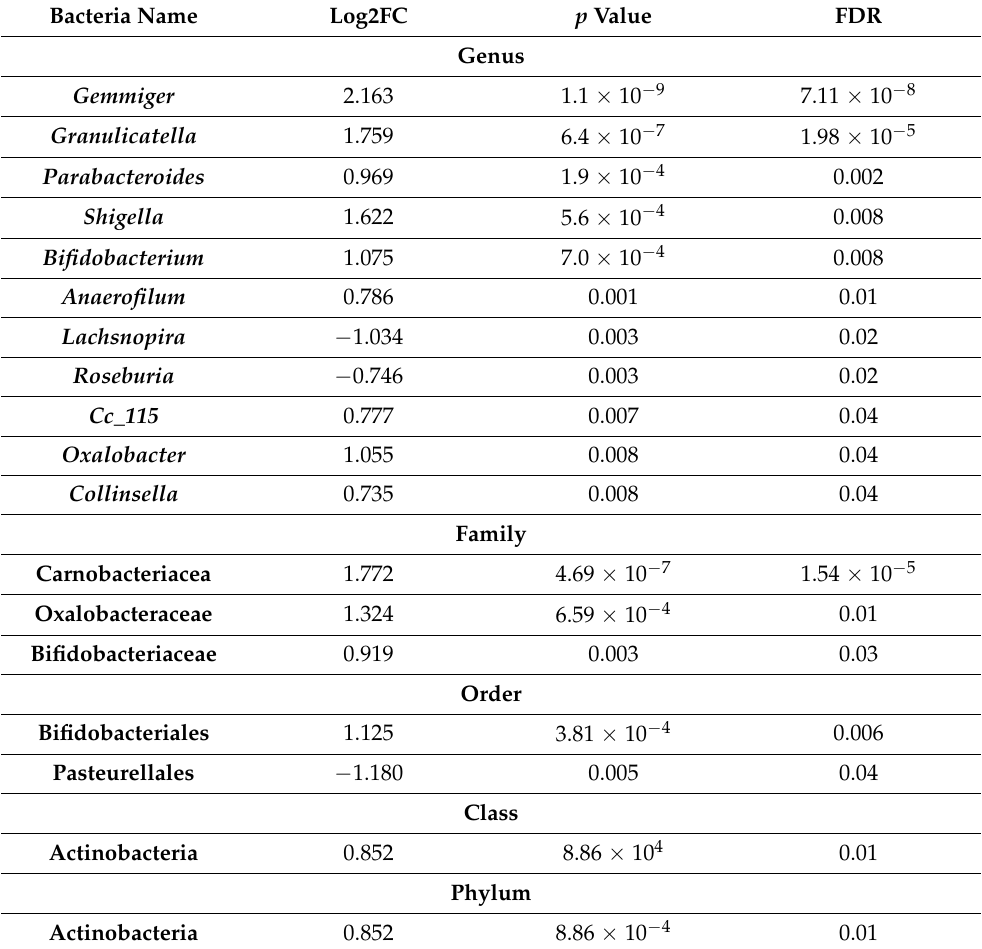
Table 3. Bacterial taxa significantly different between subjects who consumed less than 3 serv/d of adjusted UPFs and more than 5 (from genus to phylum) analyzed by